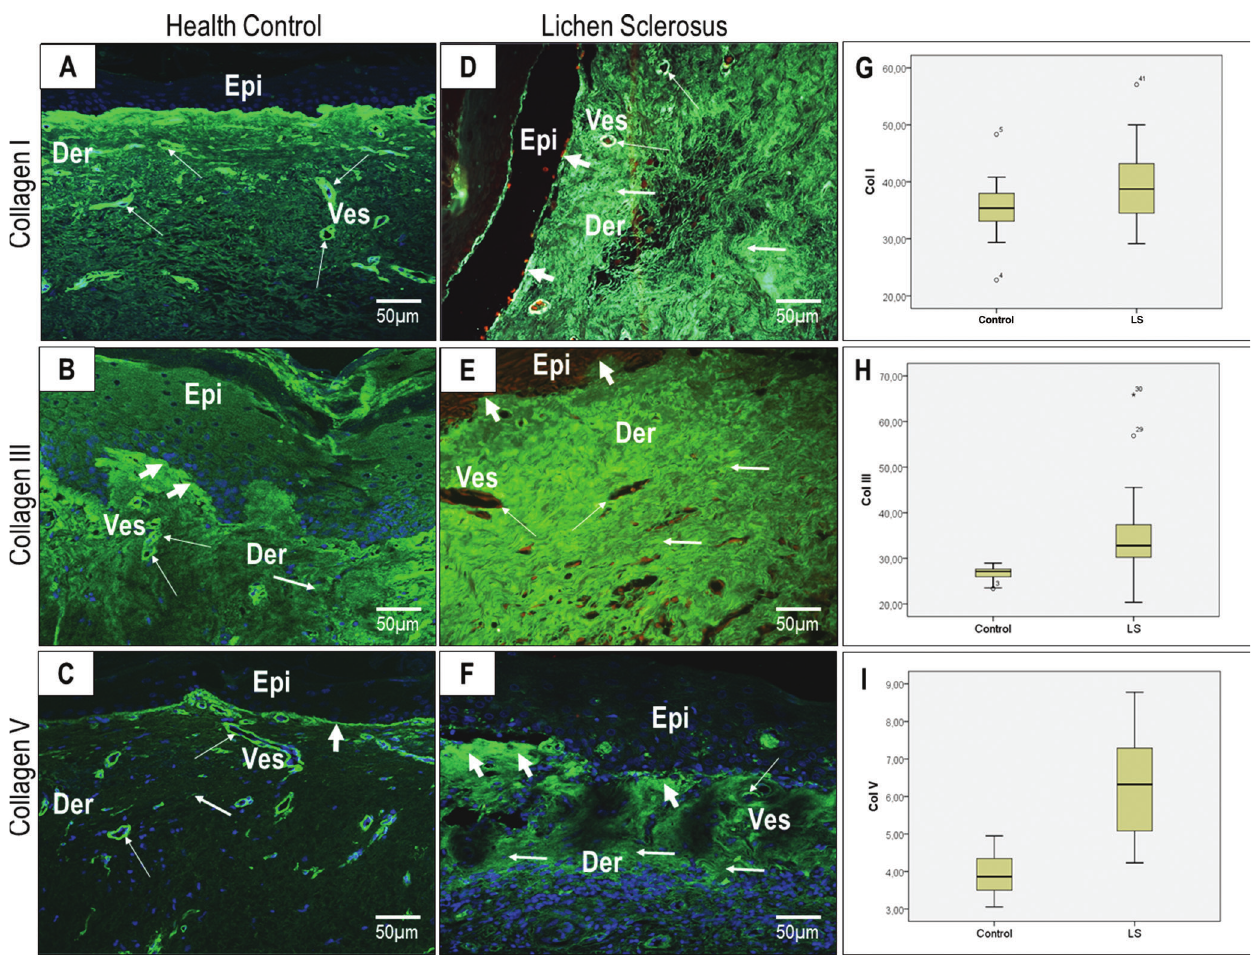
Figure 2 - Immunofluorescence, tridimensional reconstruction and quantitative expression of COLI, COLIII and COLV in the dermis of healthy controls and vulvar LS. (A) Dermis from a healthy control showing loosely arranged, green-stained COLI fibers assuming a basket-weave pattern in the dermis, along the basement membrane and sometimes around small vessels (thin arrows). (D) Vulvar LS dermis presents a similar pattern to the control, in which a basket-weave pattern of green-stained COLI fibers is also observed in the dermis (arrows), with loosely arranged fibers along the basement membrane (thick arrows), although small vessel enhancement is more prominent (thin arrows). (B) Dermis from a healthy control, showing COLIII thin fibers predominantly around the small vessels (thin arrows) and sparsely distributed in the basement membrane (thick arrows) and dermis (arrows). (E) In vulvar LS dermis, the thin green fibers are distributed around the small vessels (thin arrows); however, in contrast with the healthy control, this collagen permeates the dermis (arrows) and is irregularly distributed along the basement membrane (thick arrows). (C) COLV 3D-reconstruction in the dermis of a healthy control, with loosely arranged, thin COLV fibers showing a wavy distribution throughout the dermis (arrows), along the basement membrane (thick arrows) and around the small vessels (thin arrows). (F) Vulvar LS dermis presents dense COLV fibers forming irregular aggregates tightly packed in the dermis (arrows), exhibiting band distribution along the basement membrane (thick arrows) and present around the small vessels (thin arrows). (G, H, I) vulvar LS dermis shows a significant increase of COLI, COLIII and COLV expression compared to healthy controls ( p =0.03, p o 0.01 and p o 0.01, respectively). (Immunofluorescence: A-F; X400, original magnification); (Der=dermis, Epi=epidermis,